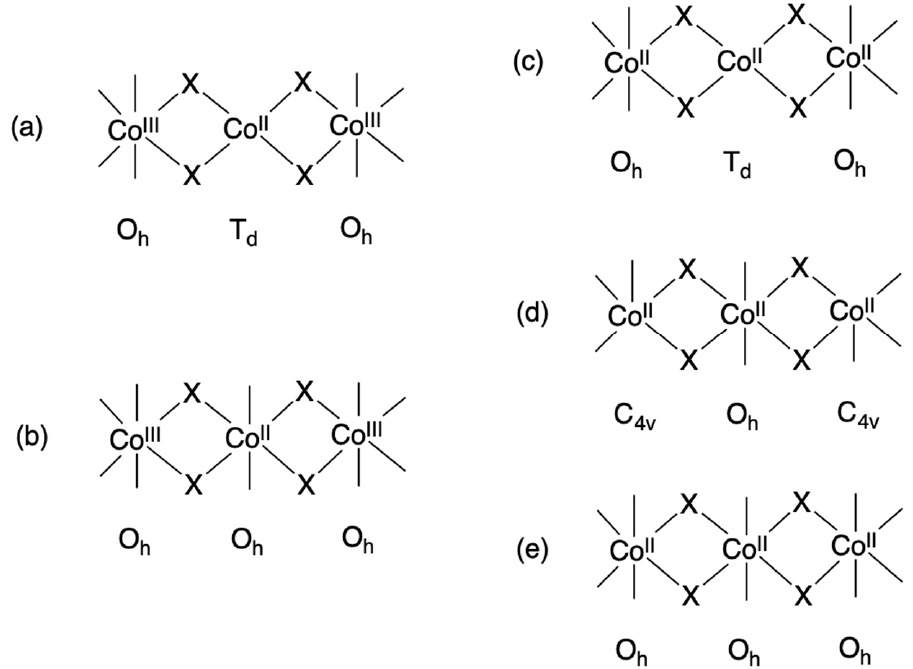
Figure 2. ( a – e ) Trinuclear cobalt complexes with a linear array of Co III -Co II -Co III or Co II -Co II -Co II .